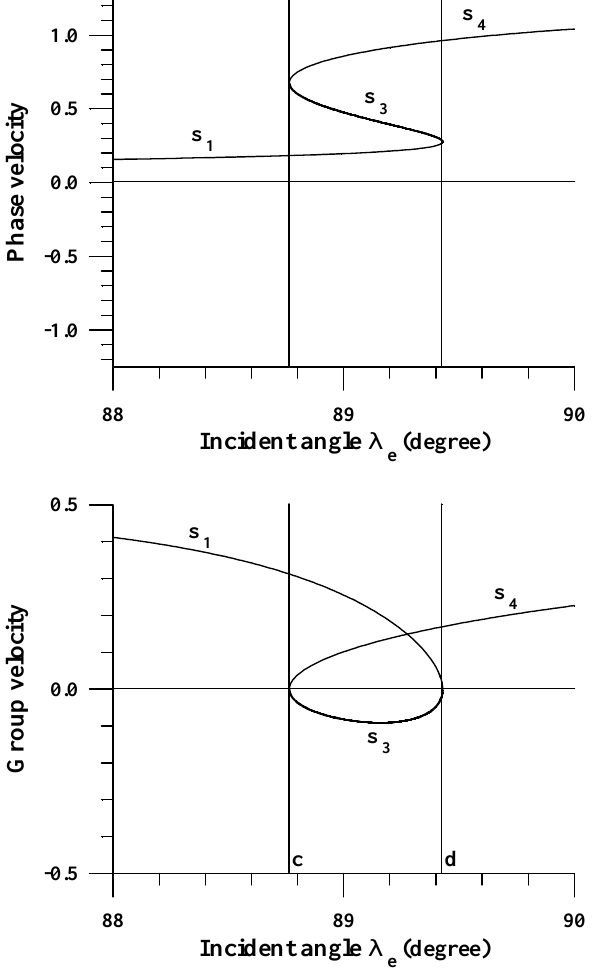
Fig. 9. X -components of the phase velocity and group velocity of the backward slow magnetoacoustic waves as a function of the inci- dent angle of the entropy wave. All velocities are normalised by the normal component of the flow velocity V x 2 behind the shock wave. Calculations are performed for the waves having the propagation angles shown in Fig. 8.